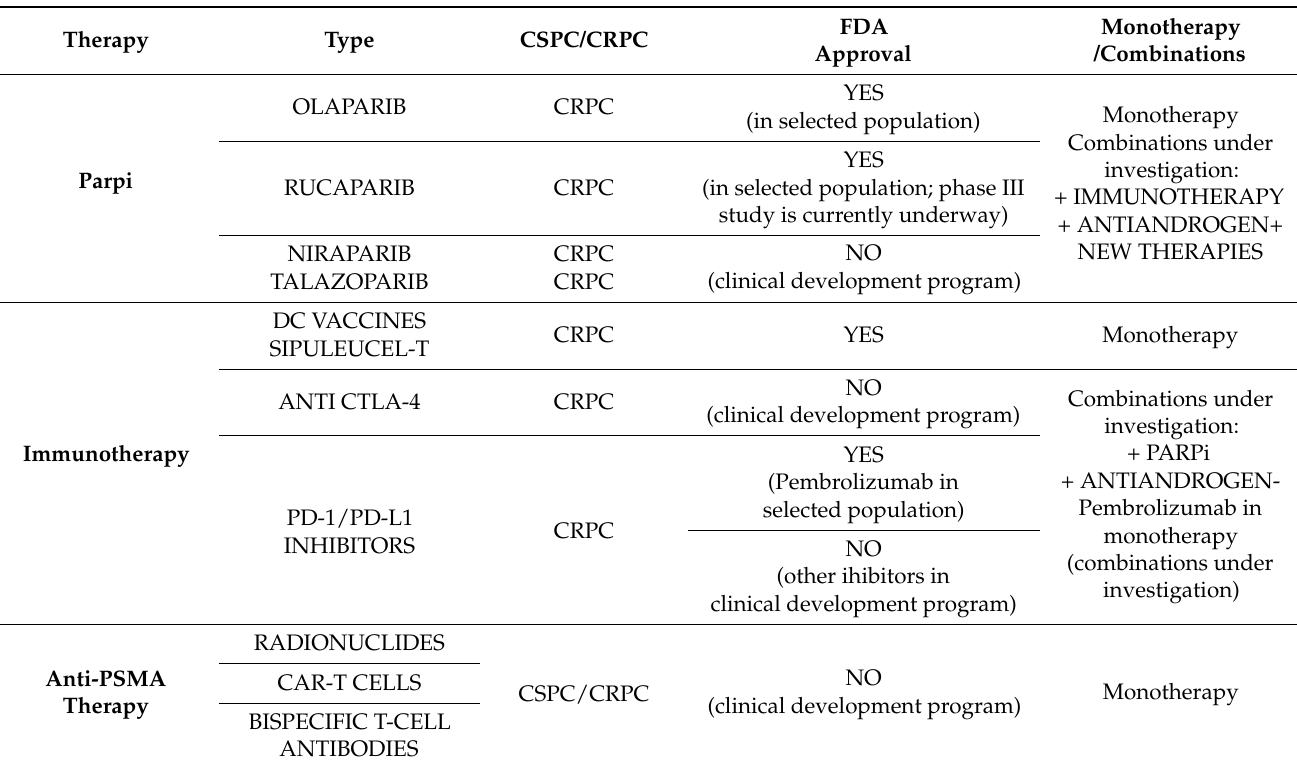
Table 2. New Therapies for